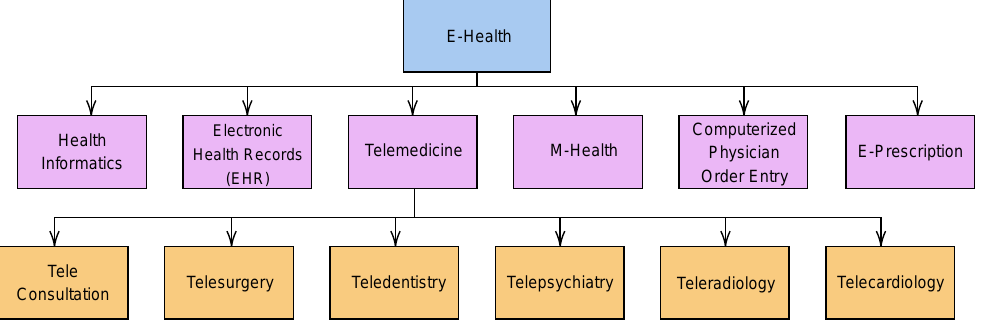
Figure 3. Major components of